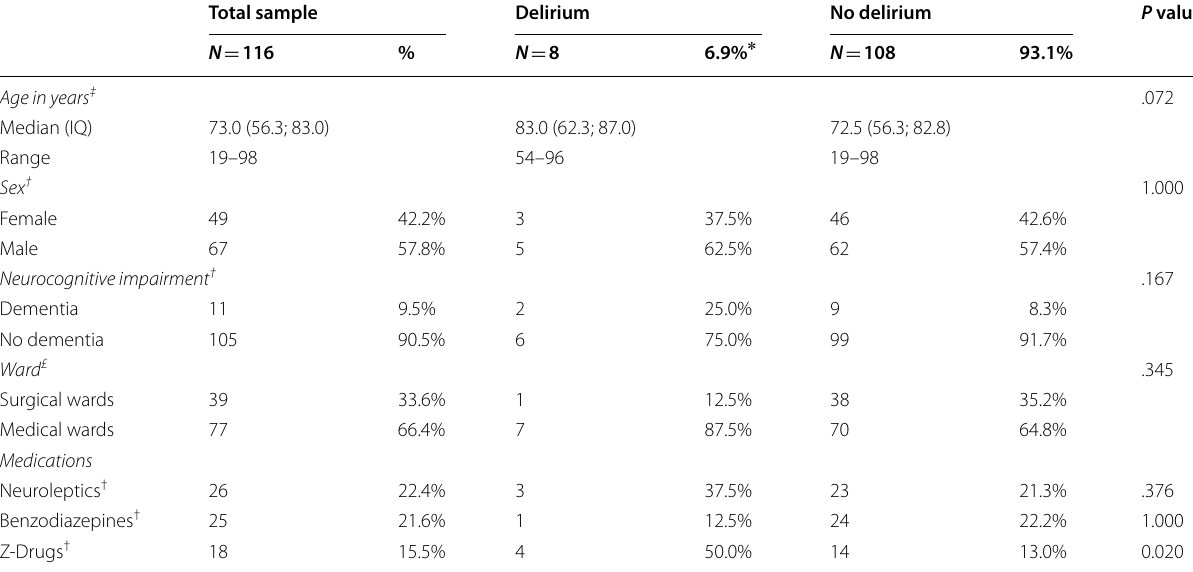
Table 2 Patient characteristics divided into delirium and no delirium